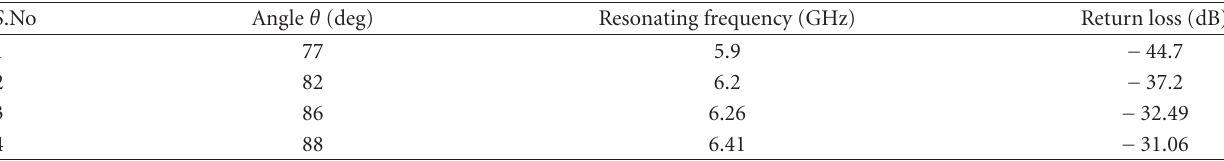
Table 1: E ff ect of tapering angle with x = 0 . 3 mm.